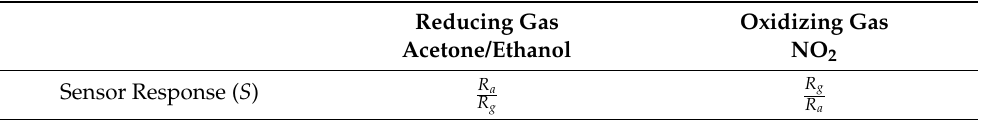
Table 2. Sensor response definition, as used in this work, and defined as a function of the nature of the gas to be detected. Gas is detected if sensor response (the ratio) is higher than 1. R a , resistance under air and R g , under